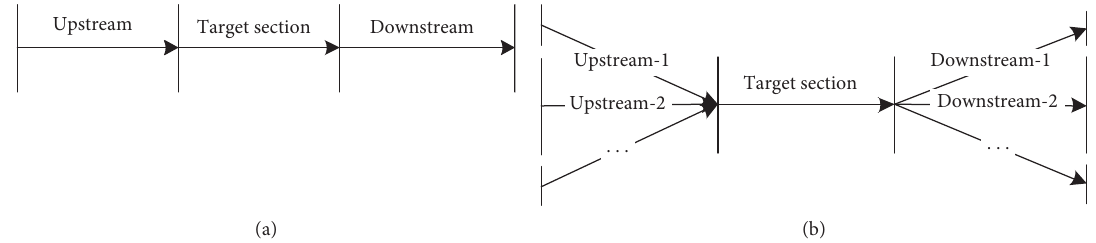
Figure 3: Multiple scenarios linking the target section with the upstream and downstream. (a) One upstream and one downstream section. (b) Multiple upstream and multiple downstream